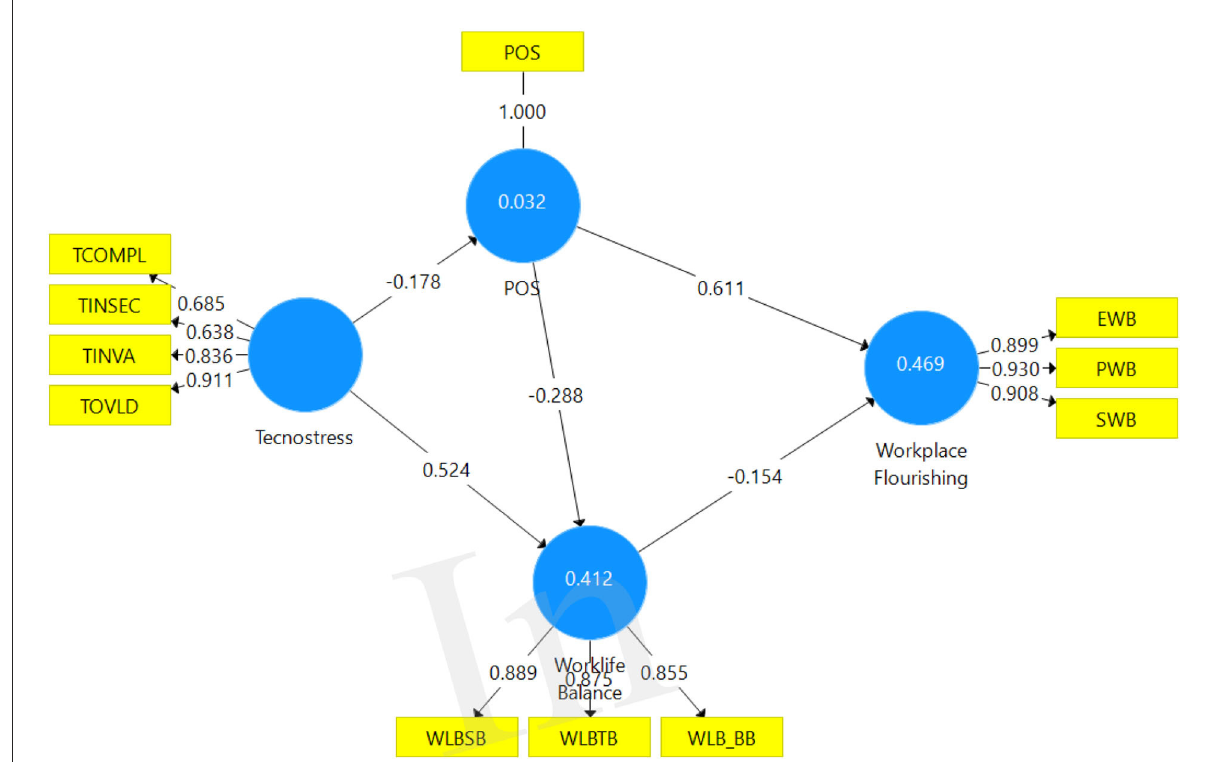
FIGURE1 The model for the influence of technostress, work–family conflict, and perceived organisational support on workplace